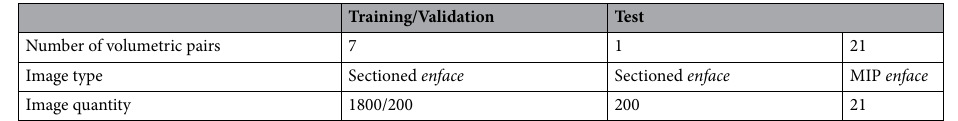
Table 1. The in-vivo mouse brain vasculature dataset used in this study. MIP, maximum intensity projection.